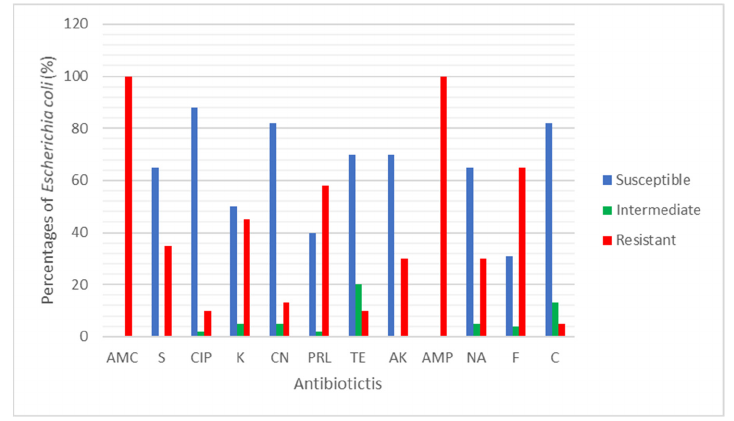
Figure 2. The percentage (%) of Escherichia coli isolated from 6 Sarawak rivers that showed Suscep- tible, Intermediate and Resistant against the 12 antibiotics tested.